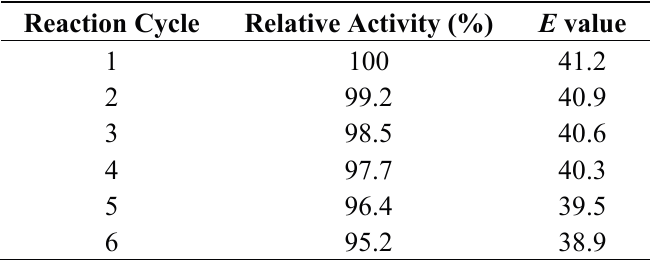
Table 5. Reusability of ionic liquid co-lyophilized CLL under microwaves. Reaction